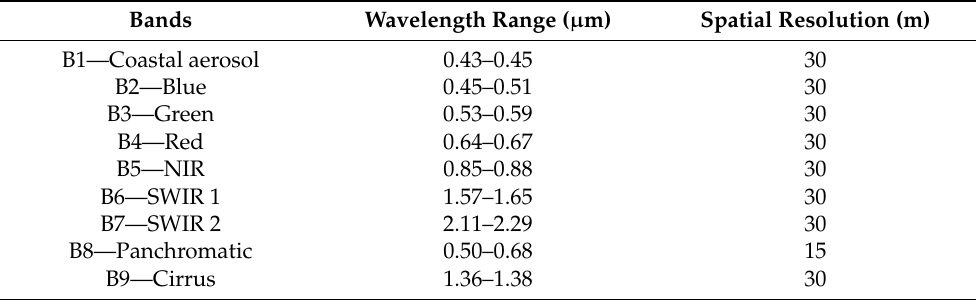
Table 1. Main characteristics of the Landsat-8 OLI sensor.